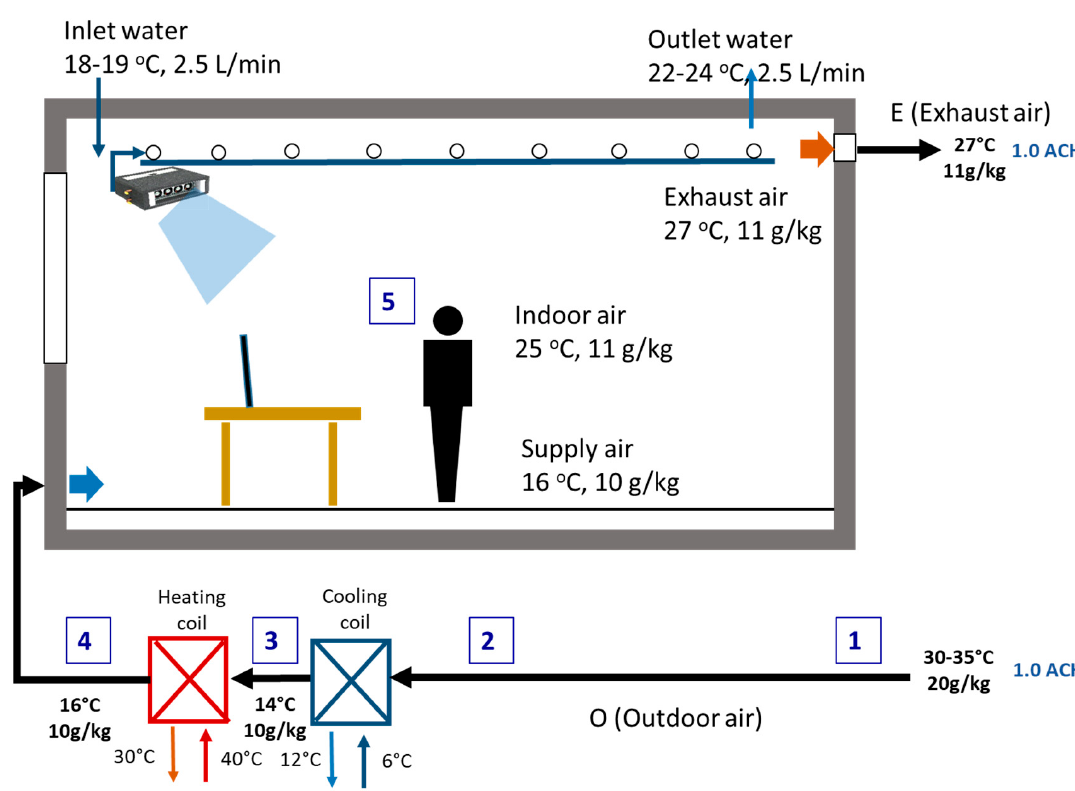
Figure 3. Schematic of the HRCS with AHU .